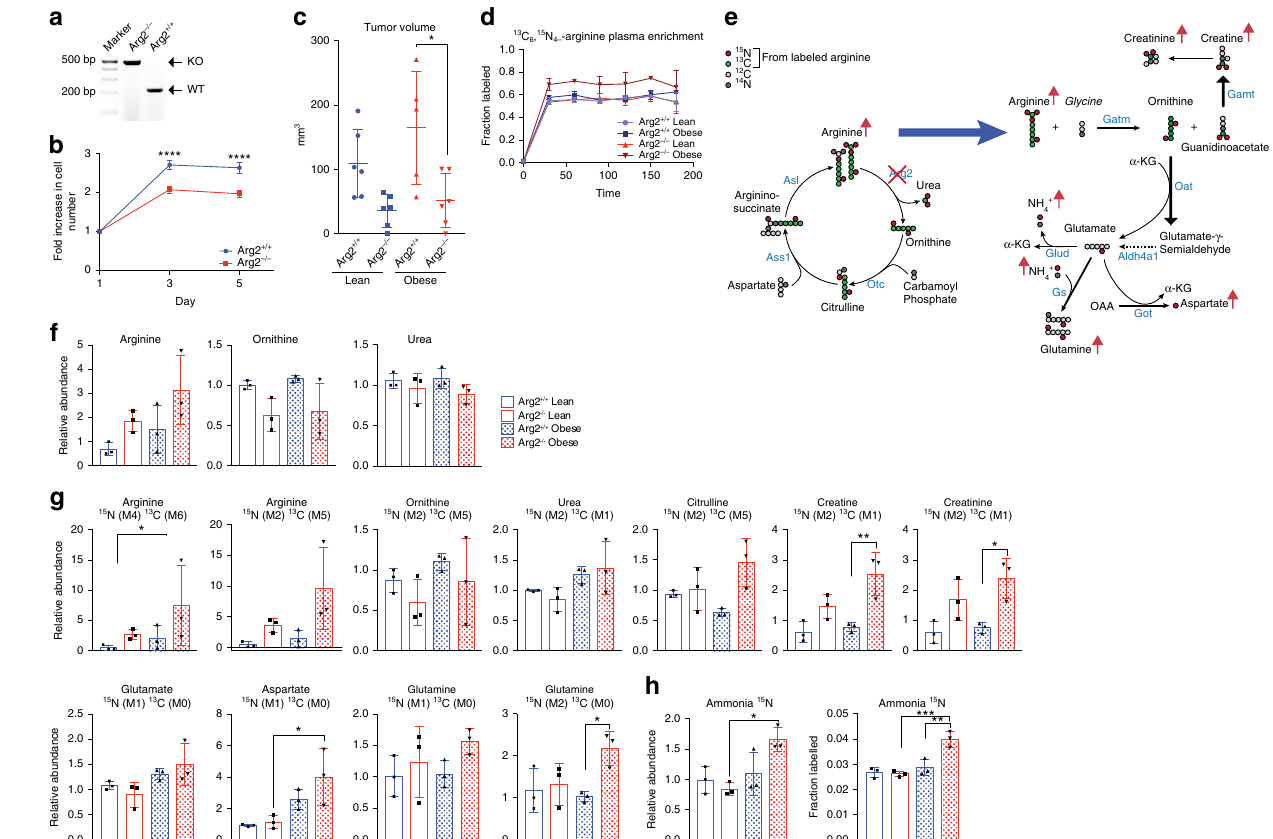
Fig. 5 Arg2 de fi ciency suppresses obesity-associated mouse PDA and results in ammonia accumulation. a DNA gel con fi rming the genotypes of KPC cells with wild-type (WT) expression or knockout (KO) of Arg2 . b Proliferation curves of cells in a ( n = 6). Data are representative of three independent experiments. c Volumes of orthotopic PDA tumors from cells in b injected (250,000 per mouse) in lean or obese 11 – 13 week old male C57BL/6J- 129 svJae mice and grown for 2 weeks ( n = 6 except for Obese-Arg2 +/+ n = 5). d 15 N 4 , 13 C 6 enrichment in plasma arginine in mice from c infused with 15 N 13 C = 3). e , Schematic showing that Arg2 knockdown in obese PDA causes shunting of arginine away from the urea cycle and towards 4 , 6 -arginine ( n creatine biosynthesis, along with transfer of nitrogen into glutamate, aspartate, glutamine, and ammonia in Arg2 − / − KPC tumors of obese mice. Red arrows indicate increases in 15 N-labeling, of indicated metabolites in Arg2 − / − tumors of obese mice. Gamt, Guanidinoacetate N-Methyltransferase. f Relative abundance of total pool of the indicated metabolites from tumors in c . g Relative abundance of the indicated labeled isotopomers in tumors from c . h Relative abundance ( left ) and fractional labeling ( right ) of derivatized 15 N-ammonia. Data represent the mean ± s.e.m. in b , or mean ± s.d. in c , d , f – h . * P ≤ 0.05, ** P ≤ 0.01 and *** P ≤ 0.001, **** P ≤ 0.0001, by two-way ANOVA in b , and one-way ANOVA in c , f – h , followed by Tukey